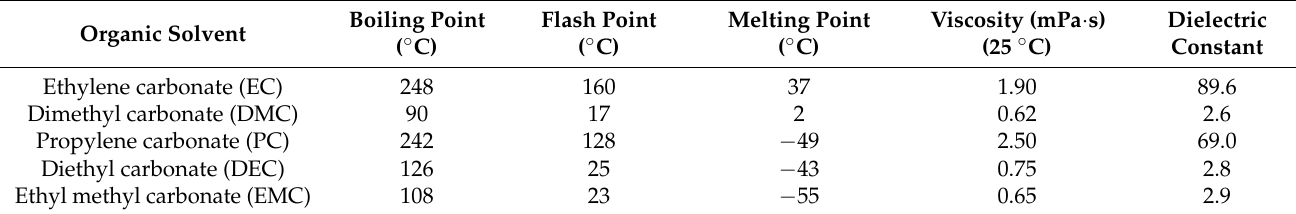
Table 1. The initial characterization of common lithium-ion battery electrolyte solvents. Organic